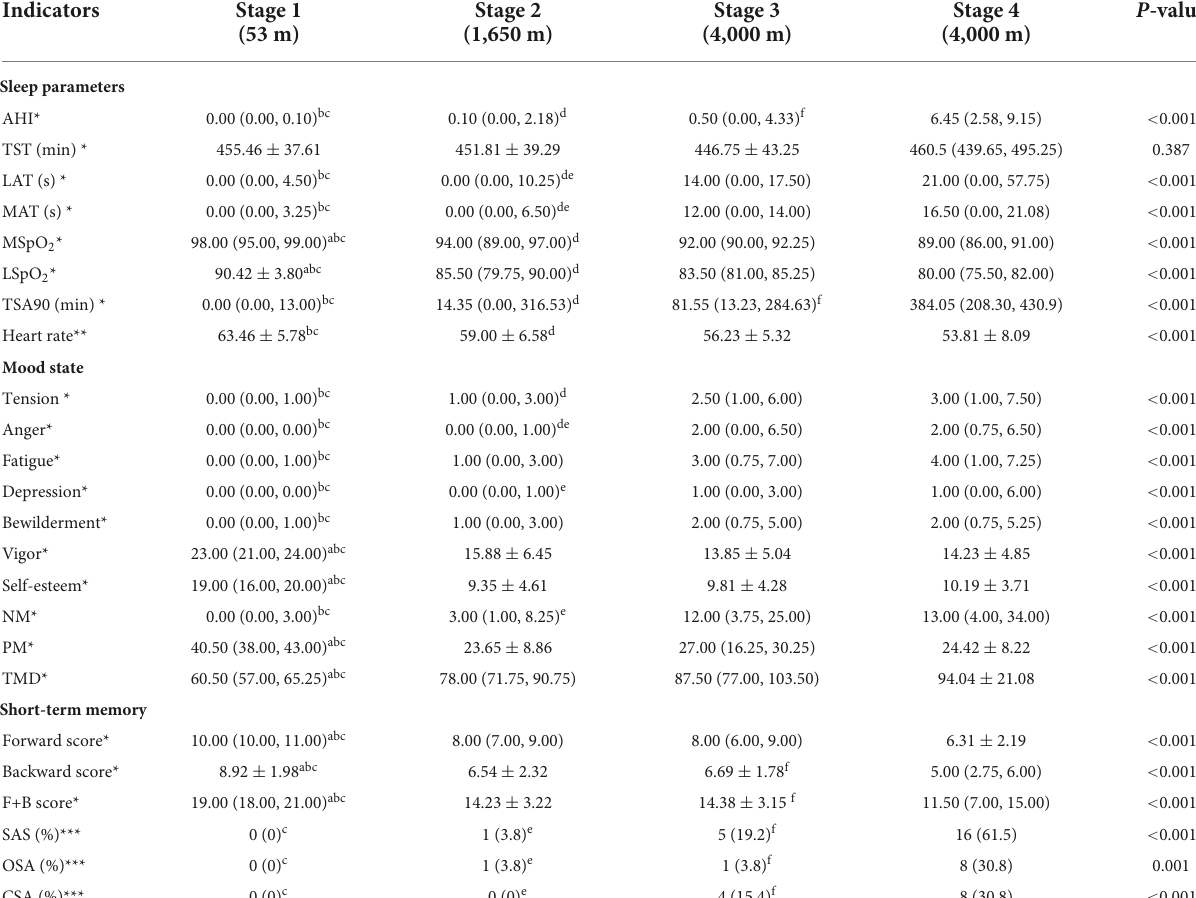
TABLE 1 Characteristics of participants for different